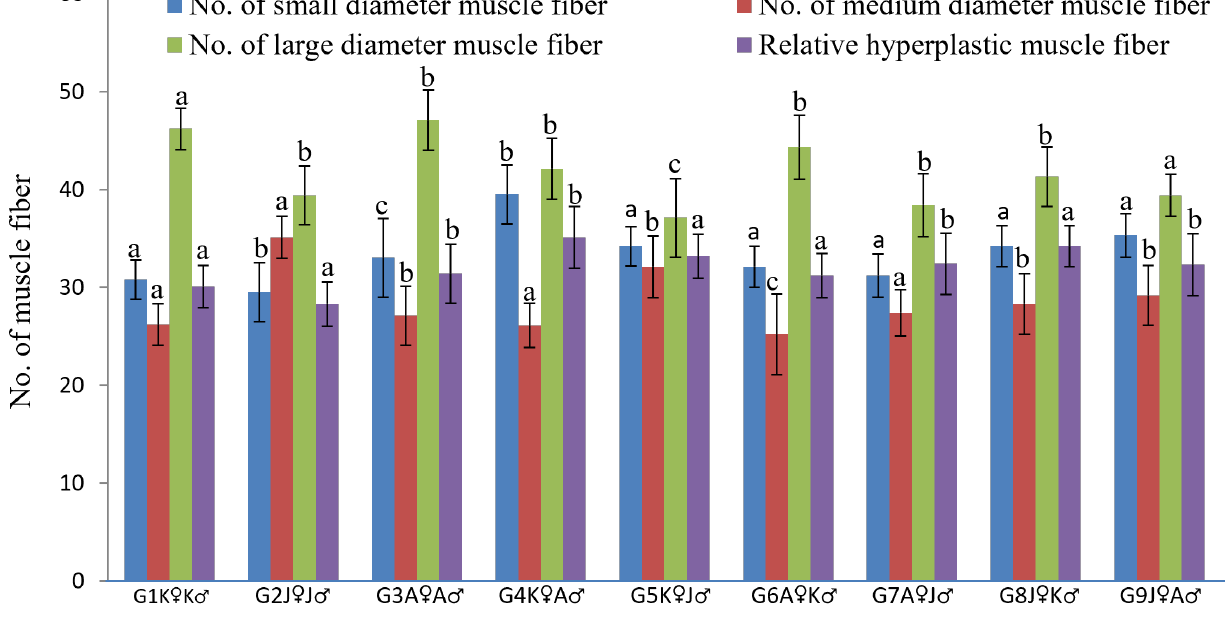
Figure 5. Muscle fiber morphometrical variation of different crossbred groups of Ariza labeo ( L. ariza ) F1 generation (different letters above the error bar indicate the significant difference between the crossbred groups for each parameter). The single words picked to naming the purebred and crossbred groups bear the full forms as G → Group, K → Kangsha River stock, J → Jamuna River stock and A → Atrai River stock. Table 7. Pairwise matrix of Nei’s genetic Distance (Nei, 1972) (below diagonal) and gene flow (Nm) (above diagonal) of nine different groups of Ariza labeo ( L. ariza ). The single words picked to name the purebred and crossbred groups bear the full forms as G → Group, K → Kangsha River stock, J → Jamuna River stock and A → Atrai River